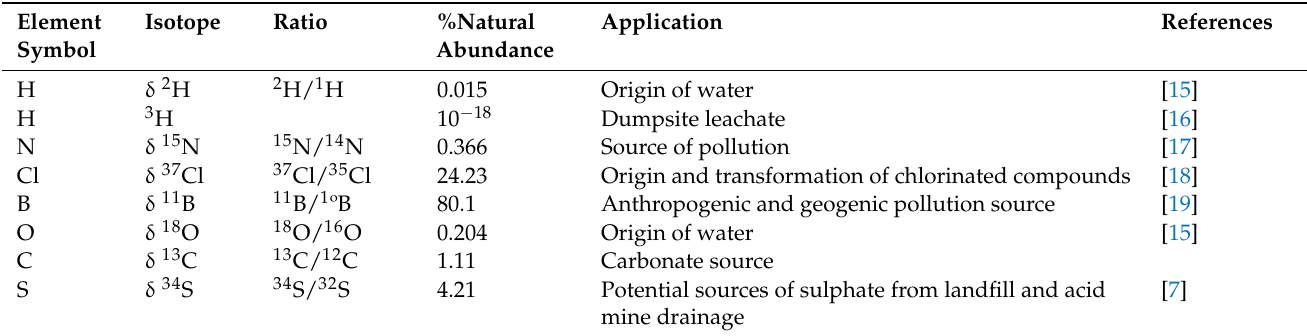
Table 1. Environment isotopes used for various groundwater